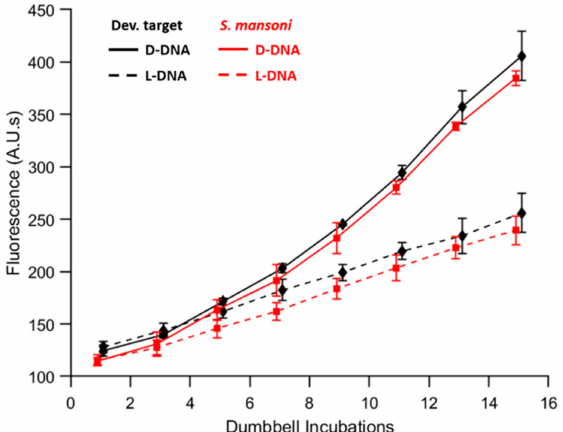
Figure 8. Comparison of autoPiLOT performance for detection of the development target sequence (black) and the S. mansoni target sequence (red). D-DNA signals are shown as solid lines, and L-DNA signals as dashed lines. The mean of three trials ± one standard deviation is